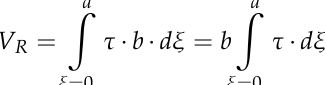
Figure 4. Comparison of load capacity of reinforced concrete beams and compressive strength.